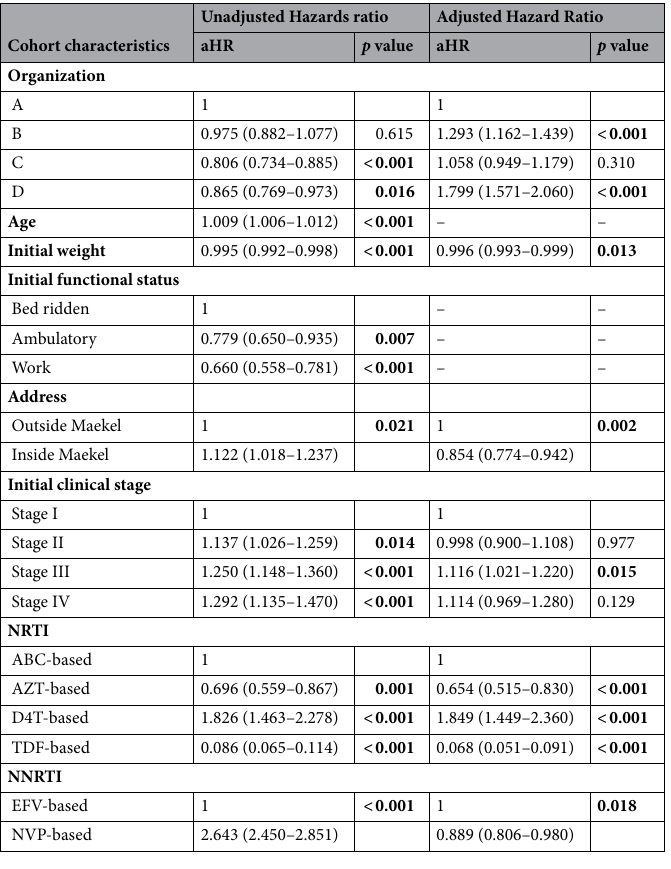
Table 4. Cox-proportional hazards for factors associated with modification of initial cART regimen among PLWHA in hospitals of Asmara, 2005–2021. Significant values are in bold. TDF, Tenofovir disoproxil fumarate; FTC, Emtricitabine; AZT, Zidovudine (AZT); 3TC, Lamivudine; ABC, Abacavir; D4T, Stavudine; NVP, Nevirapine; EFV, Efavirenz. NNRTI, non-nucleoside reverse transcriptase inhibitor; NRTI, nucleoside reverse transcriptase